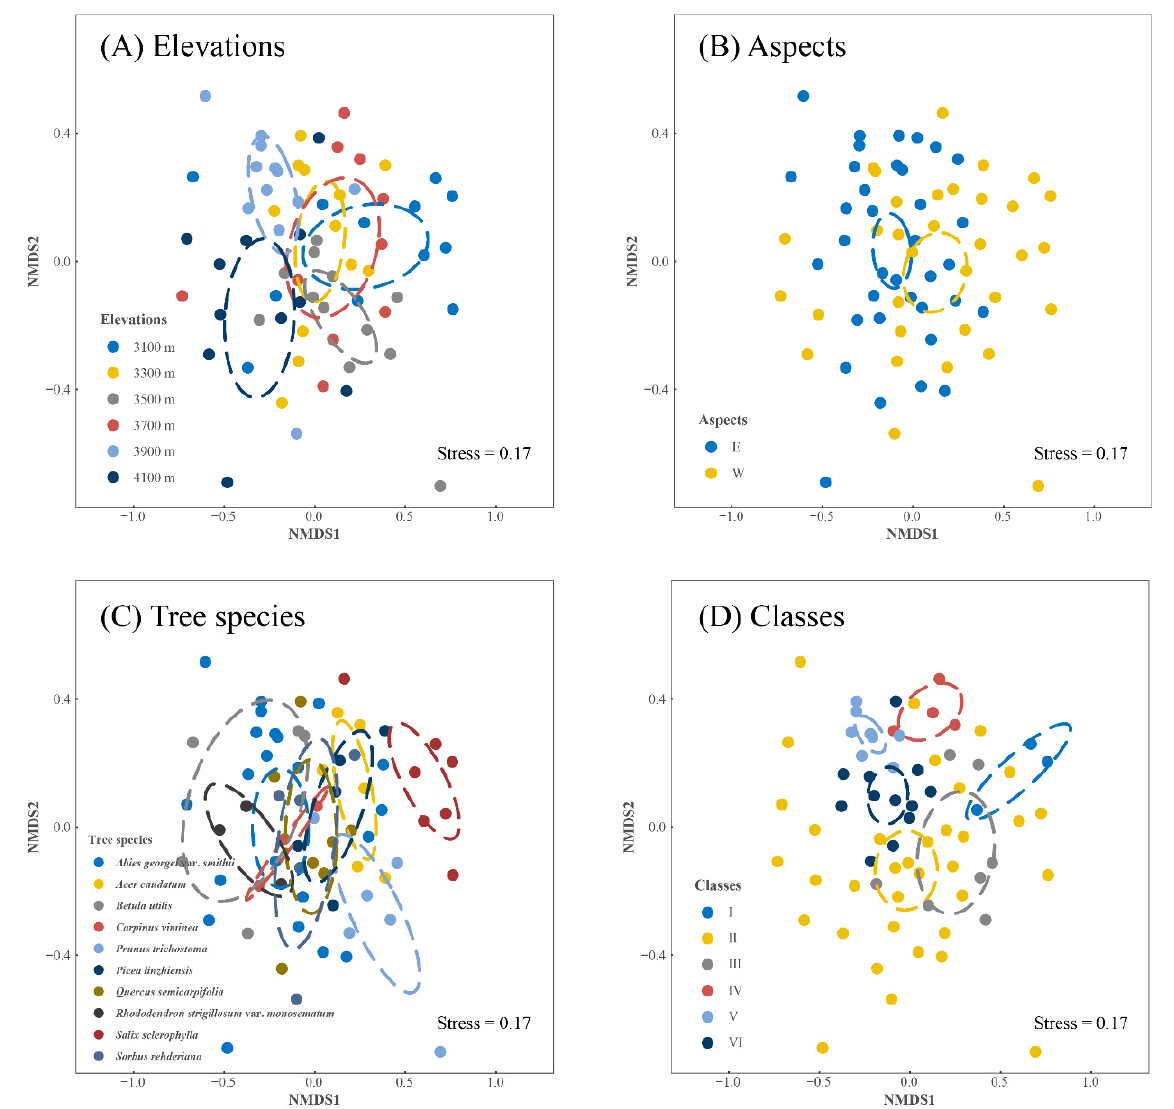
Figure 4. Bryophytes assemble under different taxonomic situations with NMDS (ordination). The positions in ordination space are shown for 72 tree sites. ( A ) based on dissimilarities among different elevation; ( B ) based on dissimilarities among different aspect; ( C ) based on dissimilarities among different tree species; ( D ) based on dissimilarities among different class (shown as letters I–VI corresponding to their classification). The ellipses were calculated around barycenters with a confidence level of 0.95.